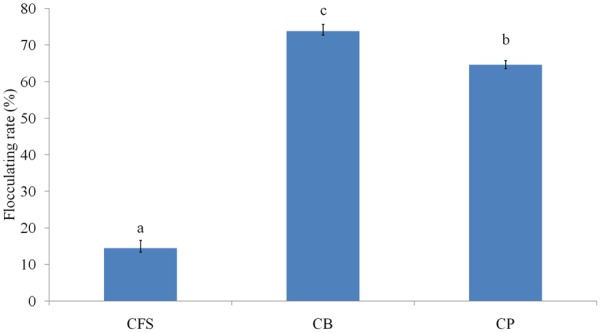
Distribution of the flocculating activity in Lactobacillus paracasei subsp. paracasei L1 cultures. CB, culture broth; CFS, cell-free supernatant; CP, cell pellet (cells harvested from the culture and resuspended in PBS). Columns with different letters indicate statistical significance (p < 0.05).